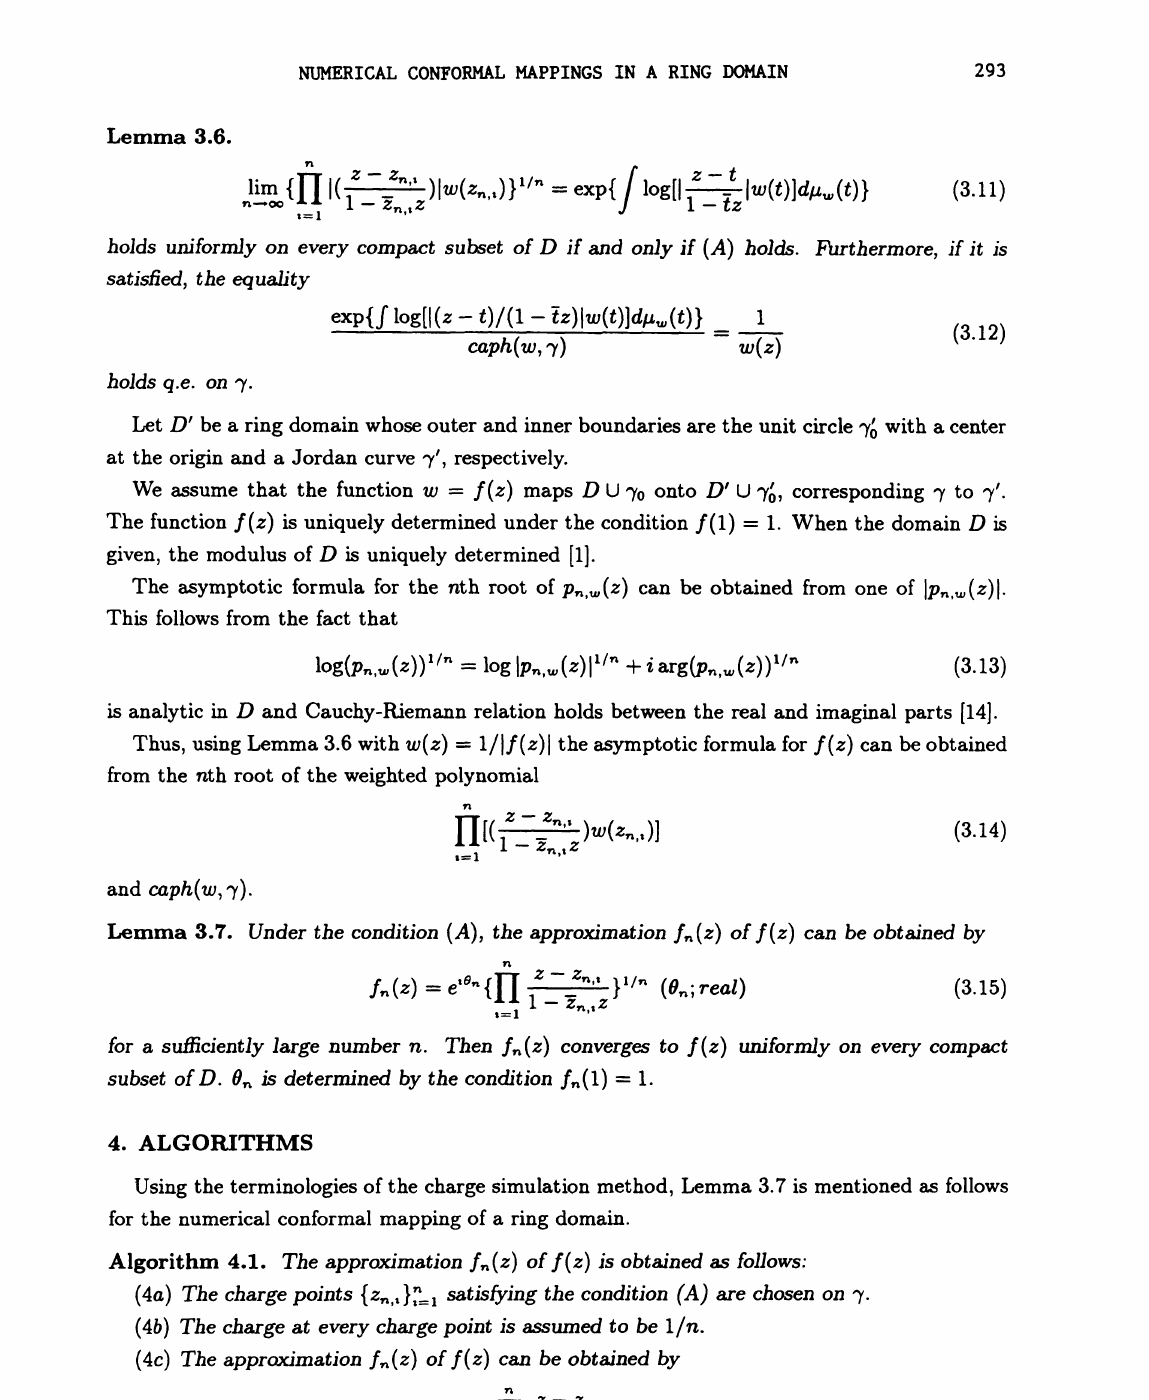
Algorithm 4.1 suggests us the following algorithm for the charge simulation method on the numerical conformal mapping of a ring